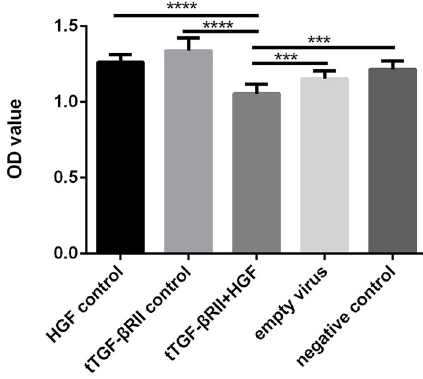
Figure 2. The proliferation of NIH-3T3 cells, which was quanti fi ed by Cell Counting Kit-8 assay, was signi fi cantly inhibited by the transfection of t-TGF- b RII/HGF-lentivirus, compared with that in the control groups (P o 0.05). Data are reported as means ± SD. ***P o 0.001 and ****P o 0.0001 (least signi fi cant difference (LSD) test). t-TGF- b RII, truncated trans- forming growth factor- b type II receptor; HGF, hepatocyte growth